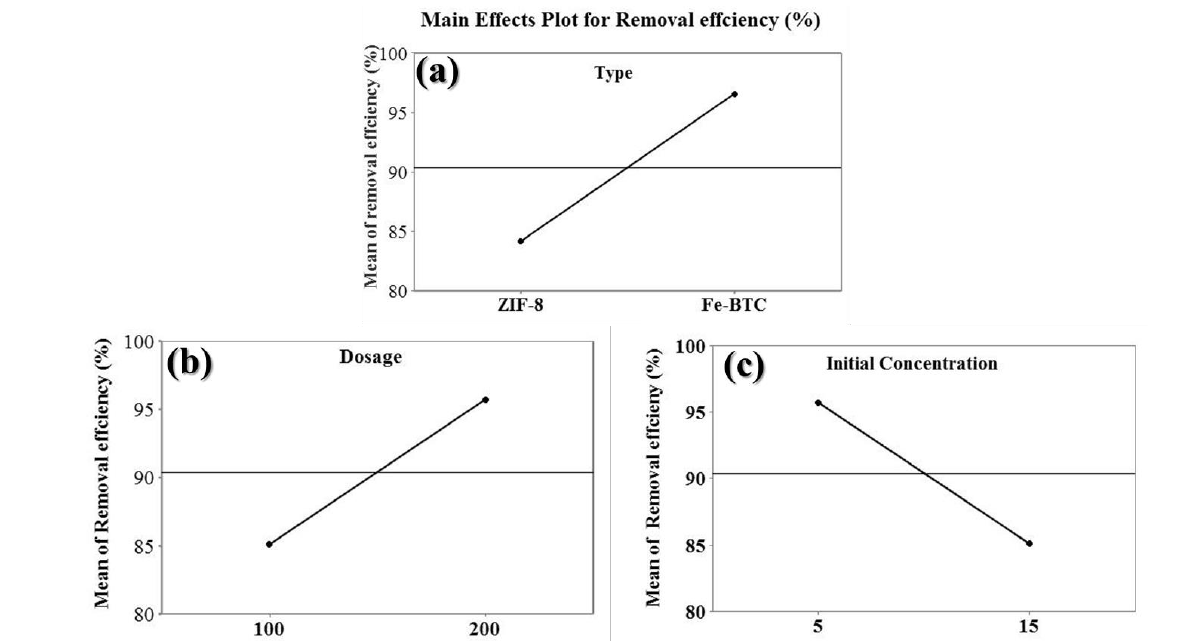
Figure 10. The main effects plot for MO removal efficiency of ( a ) type of MOF’s, ( b ) dosage, and ( c ) initial concentration of MO.